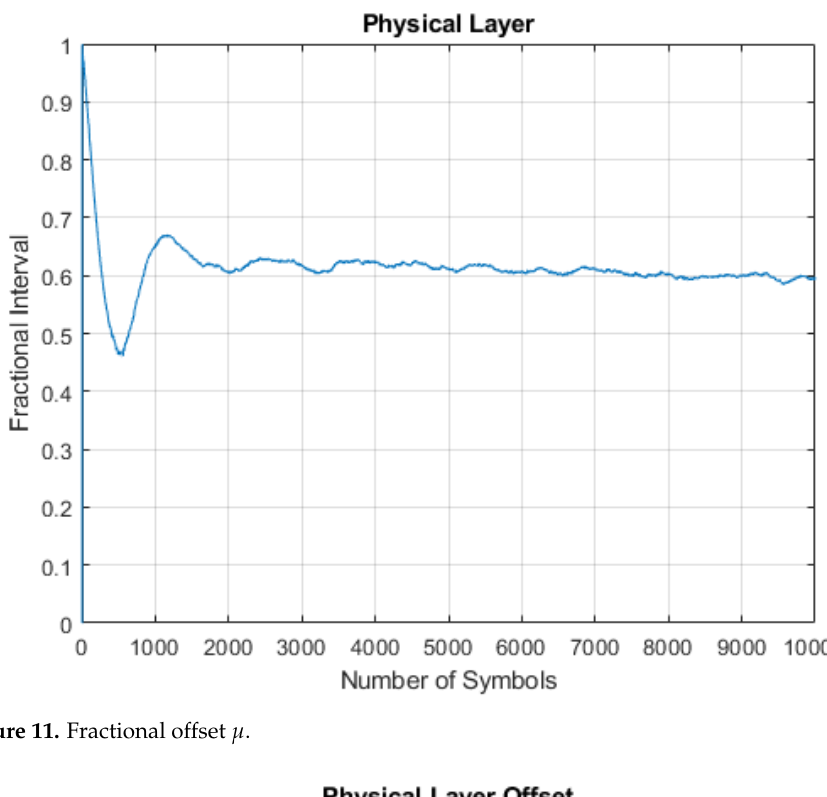
Figure 11. Fractional offset µ .